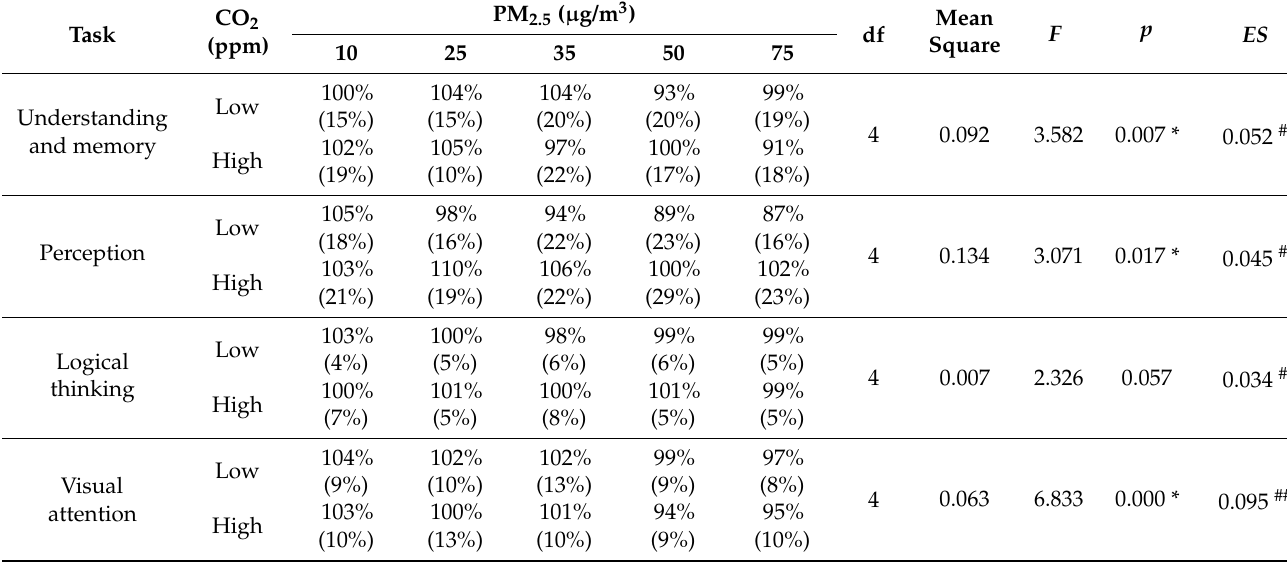
Table 8. Two-way analysis of variance (ANOVA) of four tasks performance (effect sizes of 0.01, 0.06, and 0.14 indicate small, moderate, and large